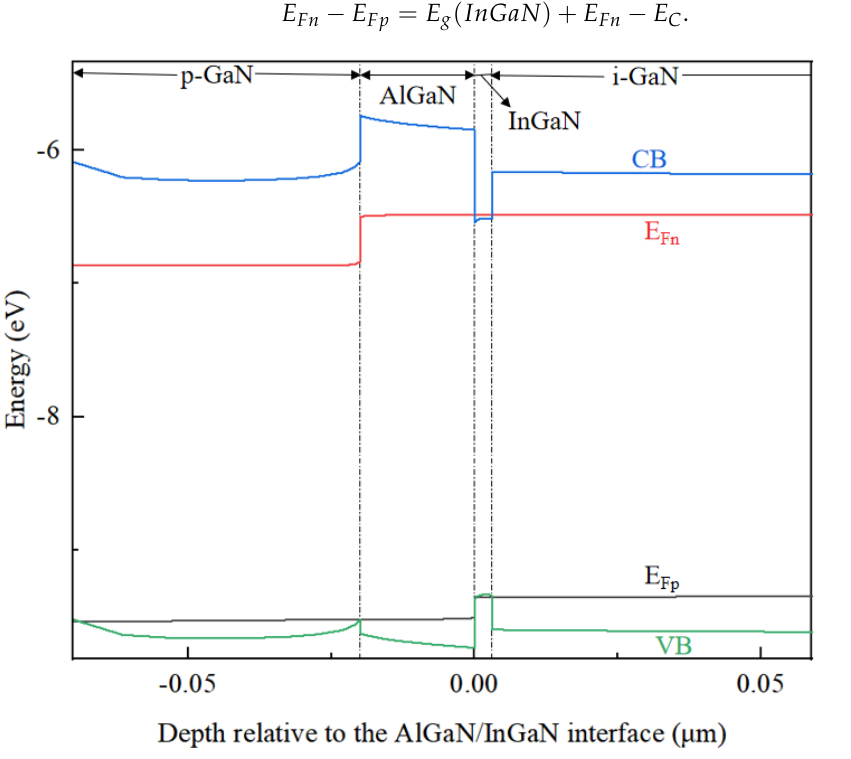
Figure 13. Energy − band diagram of an LED − HEMT at Vgs > V TH and Vds = 10V. The cutline was taken from part of p − GaN without a drain. E Fn − E C can be obtained by calculating the 2DEG density at the AlGaN/InGaN hetero ‐ interface. In the above, we established the 2DEG density calculation model of Al ‐ GaN/InGaN/GaN HEMT under the condition of V gs = 0 V, V ds = 0 V. Next, we solved the triangular barrier well at the AlGaN/InGaN interface by the Schrödinger − Poisson equa ‐ tion [29] to obtain the 2DEG density n S,D of the AlGaN/InGaN interface under the p − GaN and the condition that the device turned on at V gs > V TH’ , V ds = 10 V.